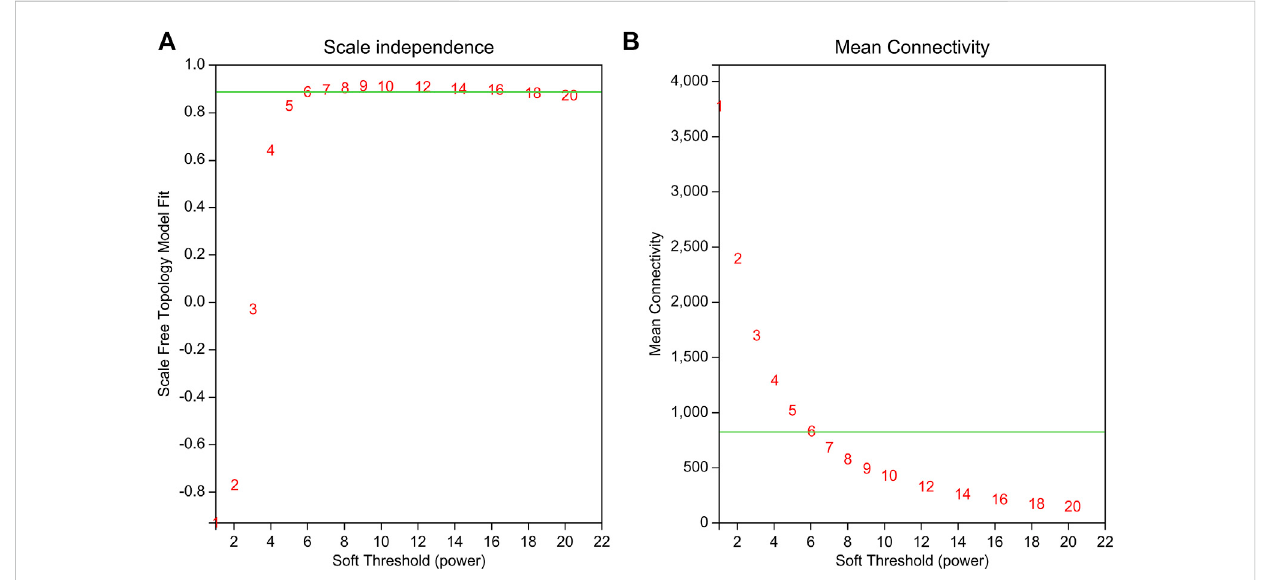
FIGURE 6 Determination of the power beta ( β ) value based on the adjacency matrix using Weighted gene co-expression network analysis (WGCNA). The weightedparameter power β valuewasdeterminedusingthescale-freetopologycriterion.Basedonthetwographsof (A) topology fi ttingresultsand (B) mean connectivity, we choose β = 6 to ensure that the average connectivity of the network was